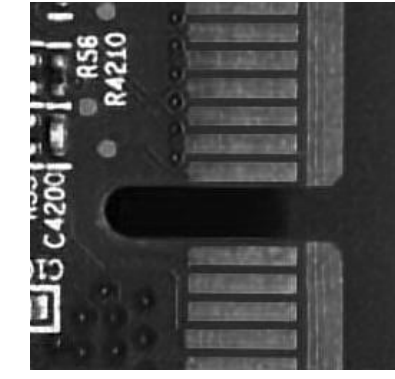
Figure 8. Examples of normal or defective samples of gold finger connector images. ( a ) Normal samples with no defects; ( b ) defective samples.